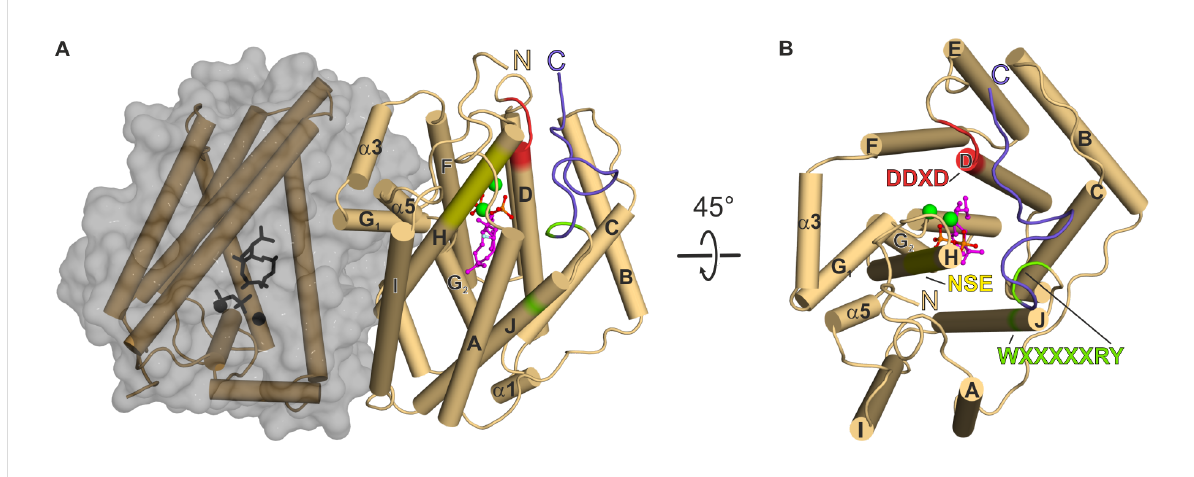
Figure 2: The bacterial diterpene synthase CotB2 wt ·Mg 2+ 3 ·F-Dola in the closed, active conformation (PDB-ID 6GGI; [37]). (A) The two monomers of CotB2 are shown in cartoon representation with the α -helices drawn as cylinders and colored in light brown. One monomer of CotB2 is shown in gray surface representation. The location of the aspartate-rich motif is indicated in red and the NSE-motif is marked in yellow. The WXXXXXRY motif is in- dicated in light-green. The last 12 C-terminal residues of the lid are drawn in violet. The three Mg 2+ ions are represented as green spheres and the bound intermediate F-Dola is shown in magenta. The cleaved diphosphate is shown in orange. (B) View of panel A rotated by 45°. For clarity, one monomer has been removed. The view is into the active site of